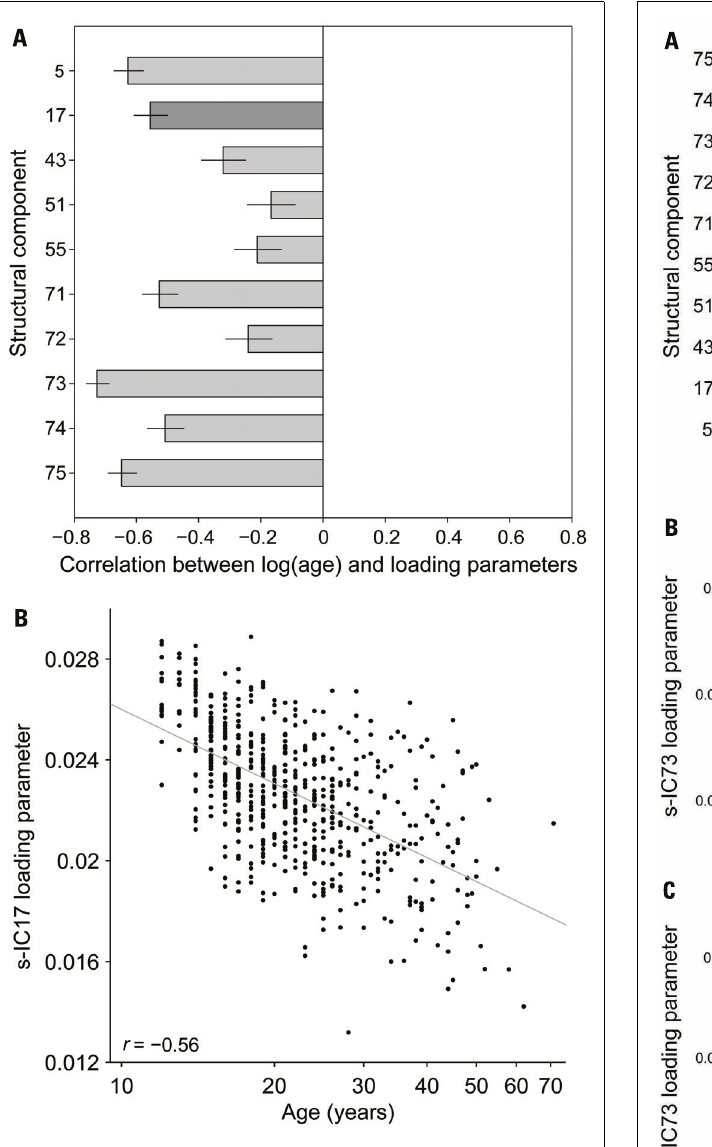
FIGURE 5 | (A) Structural components correlated to the log(age) for the 10 selected s-IC. Dark gray bar corresponds to s-IC17. In general, structural components are negatively correlated with age. Ninety-five percent confidence intervals are reported. (B) Correlation of the age (years) and loading parameter for all 603 subjects using s-IC17, which is primarily comprised of the precuneus, as an example.Where r = − 0.56.